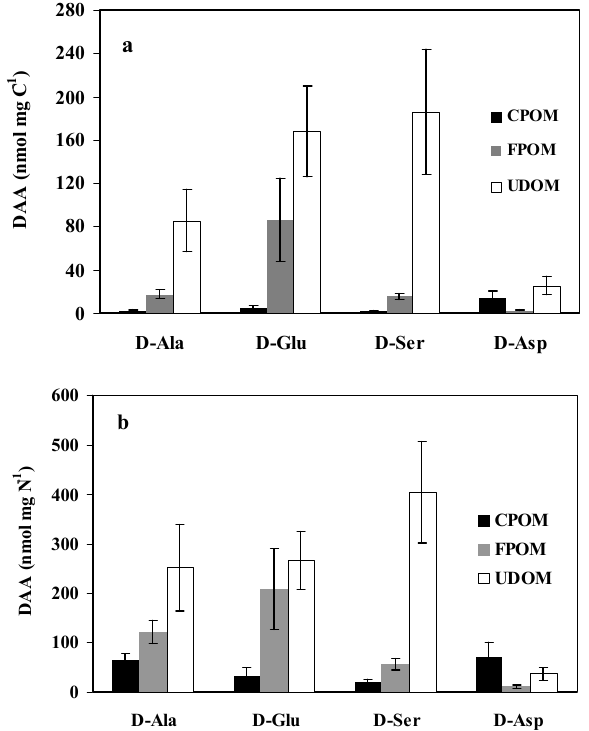
Fig. 7 Fig. 7. Spatial-averaged C- (a) and N- (b) normalized yields of indi- vidual D-amino acids (DAAs), including D-Ala (D-alanine), D-Glu (D-glutamic acid), D-Asp (D-aspartic acid), and D-Ser (D-serine) in the coarse particulate organic matter (CPOM), fine particulate organic matter (FPOM) and ultra-filtered dissolved organic matter (UDOM) size fractions. Bars represent standard